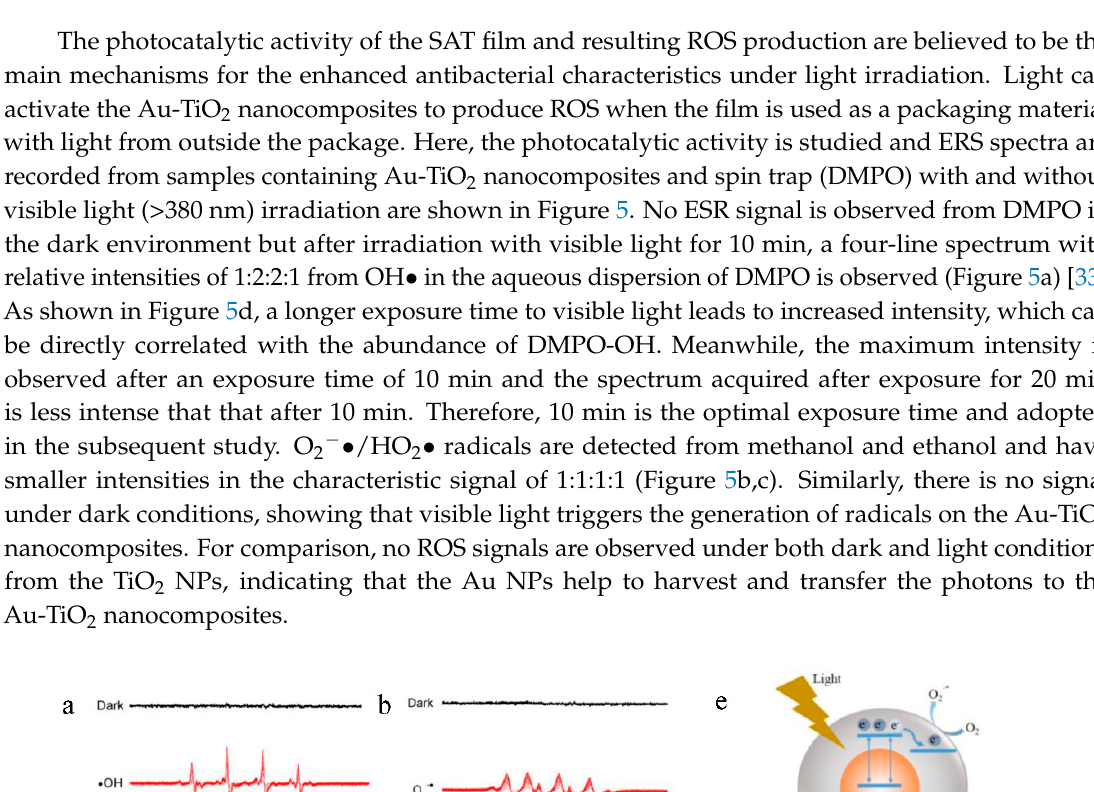
Figure 4. Antibacterial properties against S. aureus and E. coli under dark and visible light conditions.